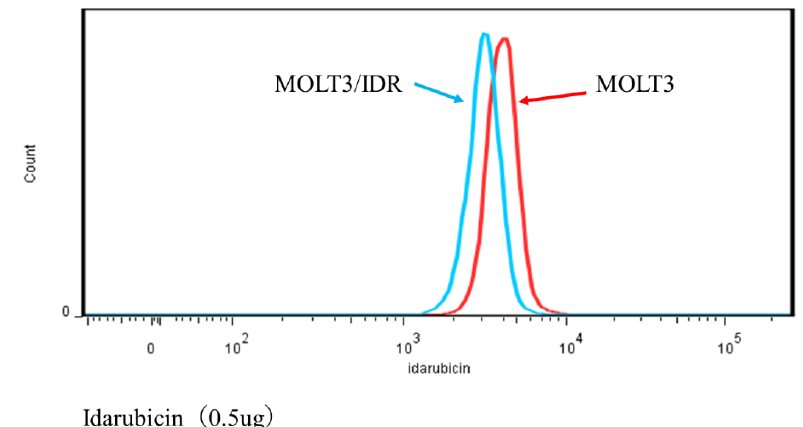
Figure 6. Histogram plots of IDR permeability at a concentration of 0.5 μg /mL in MOLT-3/IDR and